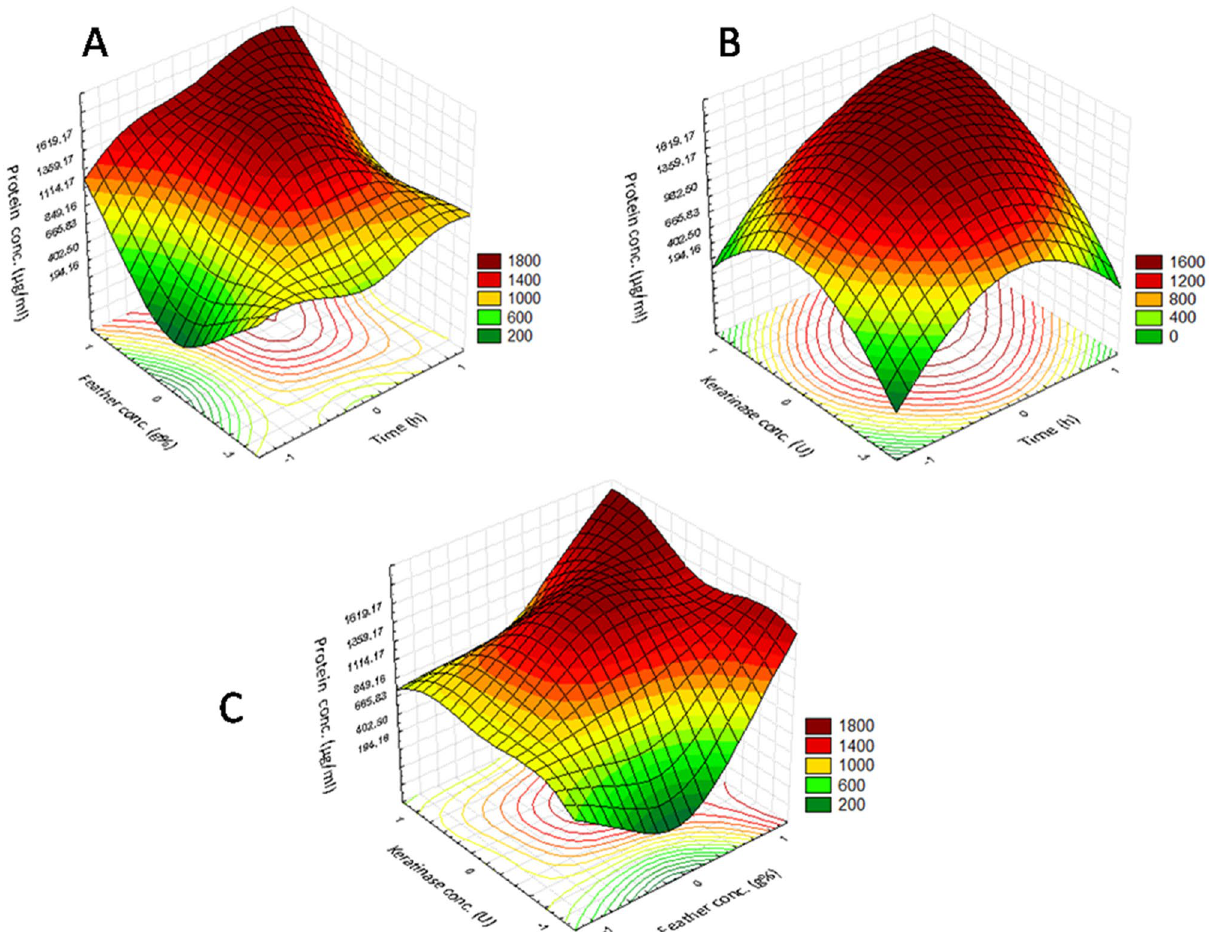
Figure 1. Three-dimensional surface plots showing the relationships between the significant variables and the protein concentration (µg/ml) in the FPL production; the optimal levels of the three factors were obtained from the maximum value of the polynomial model. ( A ) Interaction between the feather concentration and time; ( B ) interaction between the keratinase concentration and time; ( C ) interaction between the keratinase concentration and the feather